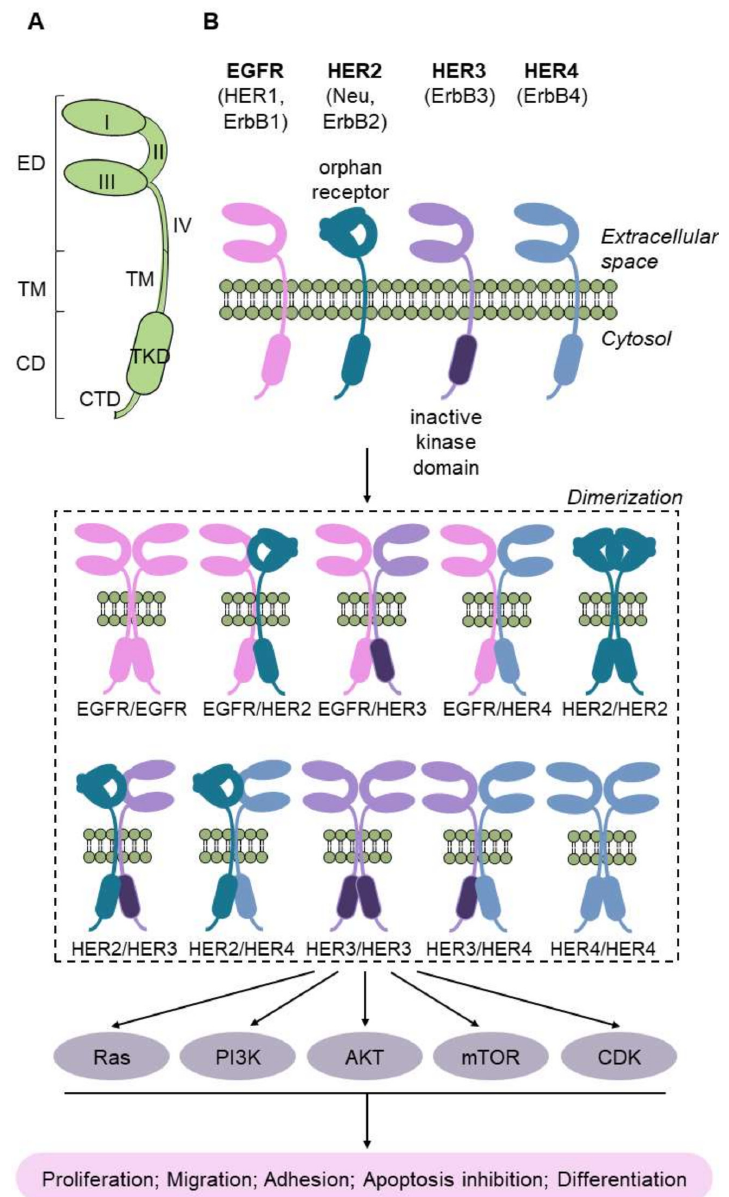
Figure 8. ( A ) Schematic representation of the three domains of an ErbB receptor. The N-terminal extracellular domain (ED) has four subdomains, with the subdomains I and II participating in ligand binding, and the II and IV subdomains participating of the receptor. TM refers to the transmembrane domain, and the cytoplasmatic domain (CD) has two subdomains more, with the tyrosine-kinase (TKD) and the C-terminal (CTD) subdomains. ( B ) Schematic representation of the 4 HER receptors and the 10 possible homo- and heterodimers. Activated HER dimers promote many signaling cascades affecting multiple key biological